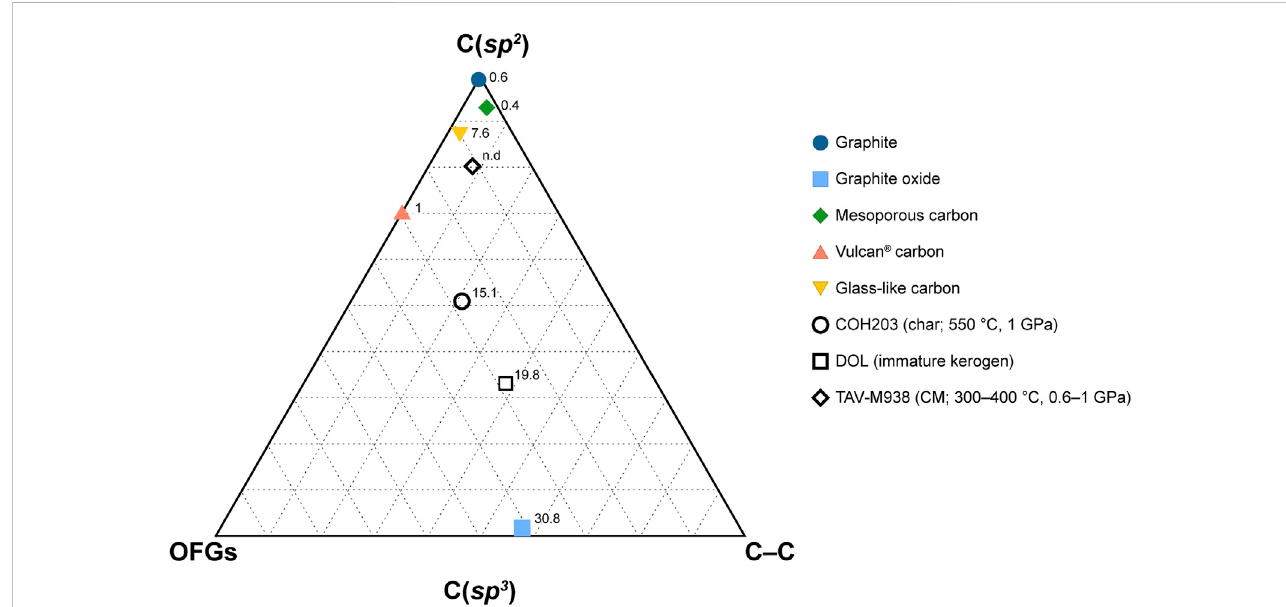
FIGURE 6 Ternary diagram reporting XPS C 1s composition of both synthetic and natural carbonaceous materials. The proportion of sp 3 -hybridized carbon is distributed between single C – C bonds and oxygenated functional groups (OFGs). The numbers next to the markers indicate the oxygen content (in at%) as found in XPS survey analysis. The data used for the construction of the fi gure are listed in Table 4.